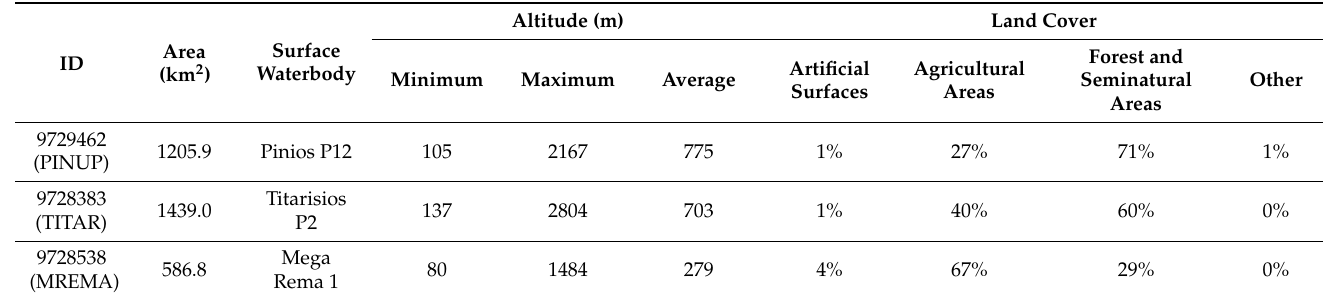
Figure 1. Orientation map of the study area of Pinios river basin and the 9729462 (PINUP), 9728383 (TITAR), and 9728538 (MREMA) sub-basins studied. The locations of the hydrometric stations used for evaluation are also illustrated. Table 1. Main characteristics of the sub-basins studied.